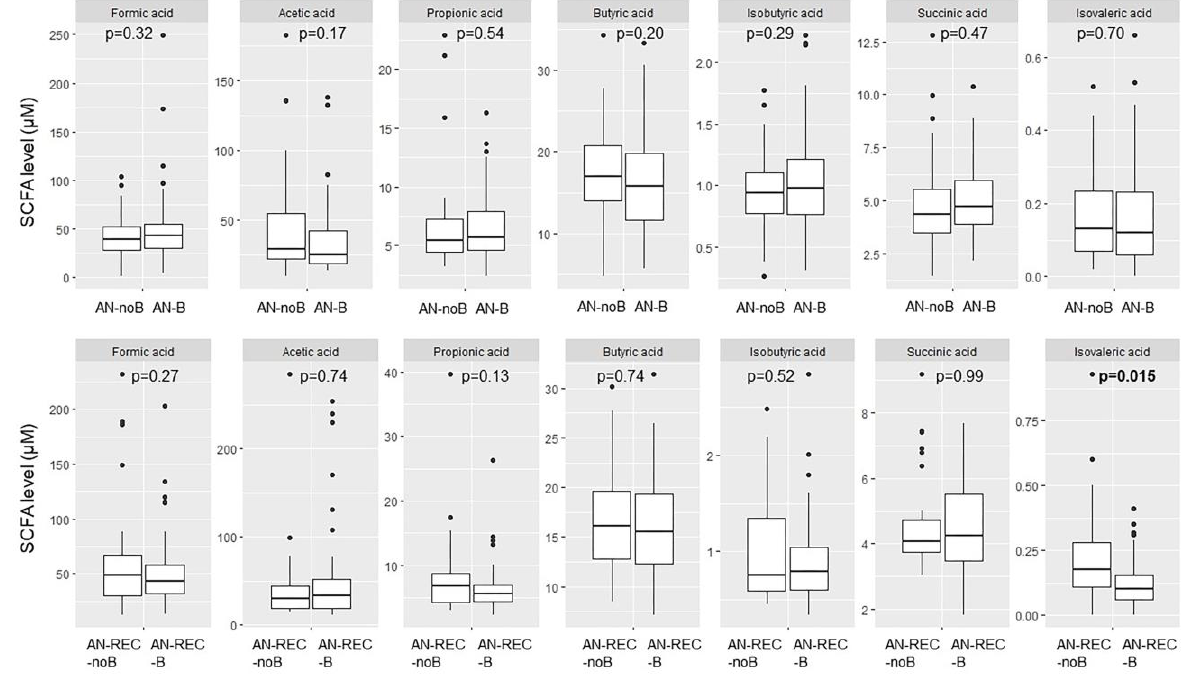
Figure 5. Box plots illustrate group differences in adjusted plasma concentration of SCFA in active and recovered AN (AN-REC) with (AN-B, AN-REC-B) vs without (AN-noB, AN-REC-noB) reported binge eating. The median is shown as a straight line and the box denotes the interquartile range. p < 0.017 is considered